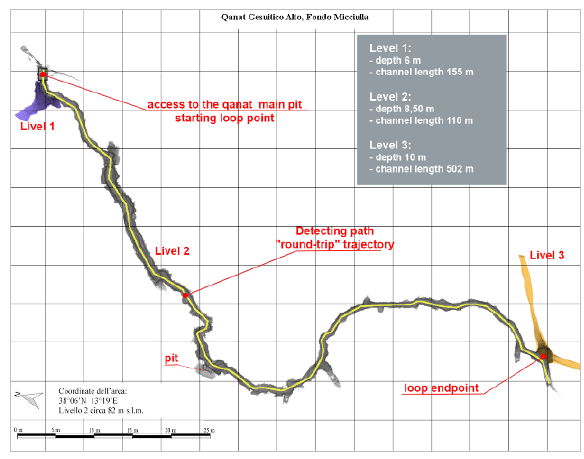
Figure 6 . Survey design with the WMLS. Strategy of "round- trip" trajectory to close the loop and to detect the undercut areas.